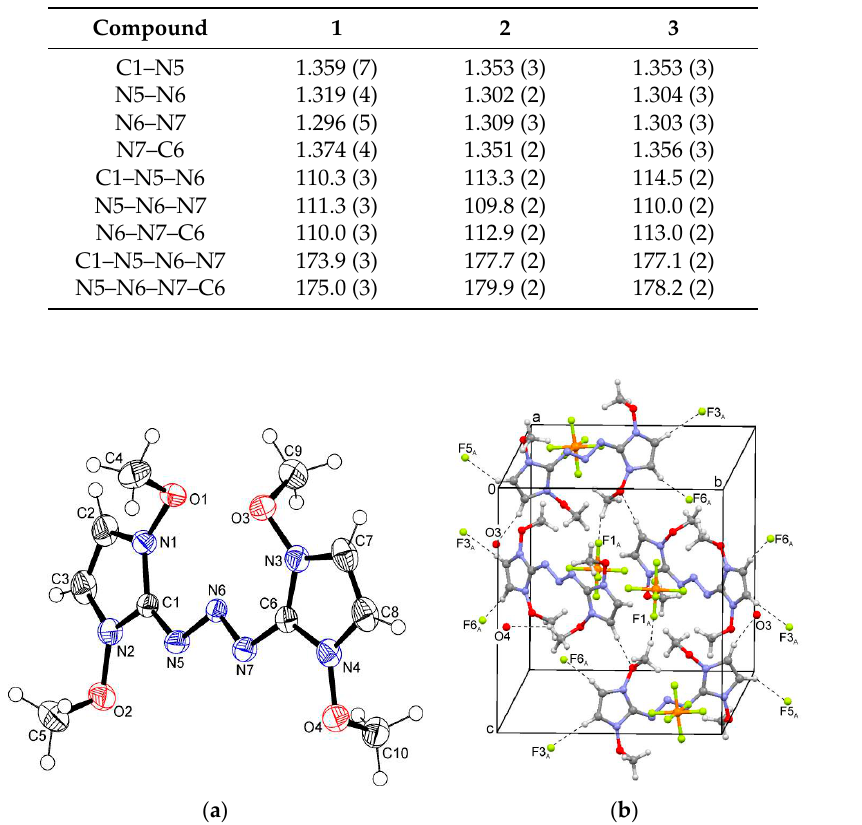
Figure 3. ( a ) molecular structure of the cation; ( b ) interactions in the crystal structure of 2 . In the structure of 3 , the heteroaromatic C7–H of the triazole donates a hydrogen bond to F5, whereas the C3–H of the imidazole forms bifurcated hydrogen bonds to F3 and F6. Aliphatic hydrogen atoms form contacts to F1, F3 and F5, as well as to O1 and N7 (Figure 4b).